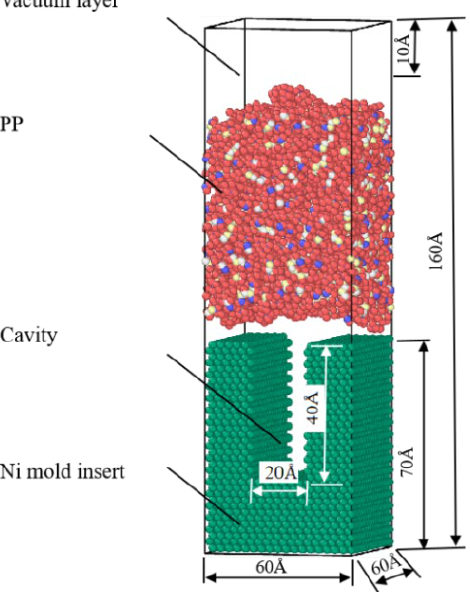
Figure 1. The polymer-melt molecular model for the injection molding process.